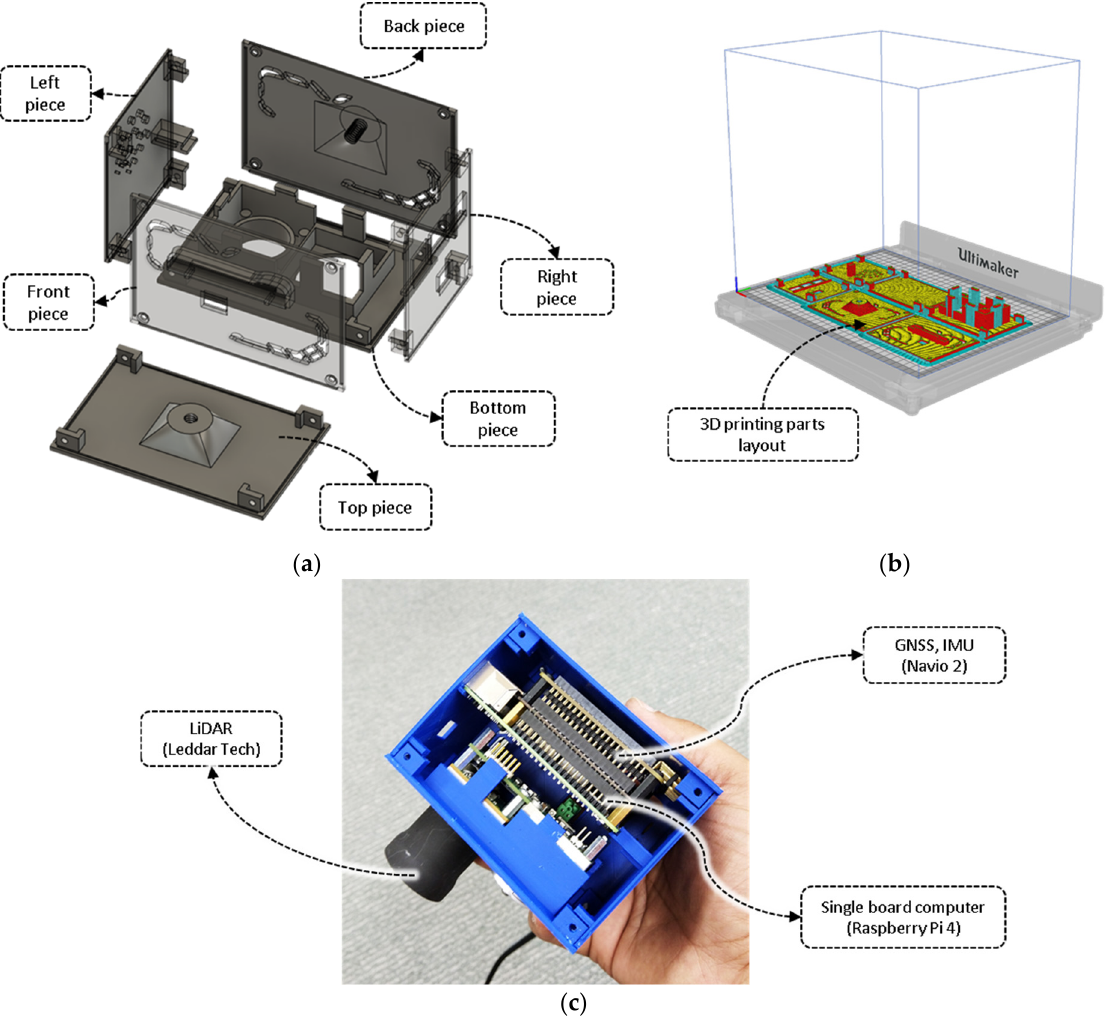
Figure 2. The CropBioMass (CBM) sensor design and development. ( a ) 3D model parts for the sensor case, ( b ) printing of the modeled parts using a 3D printer, and ( c ) encasing of the hardware units inside the printed 3D model case.